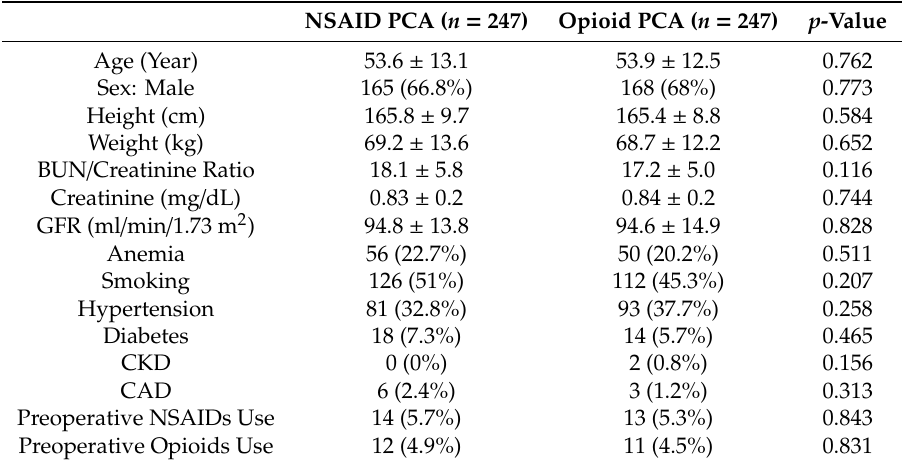
Table 1. Patient demographic characteristics and preoperative renal function test.